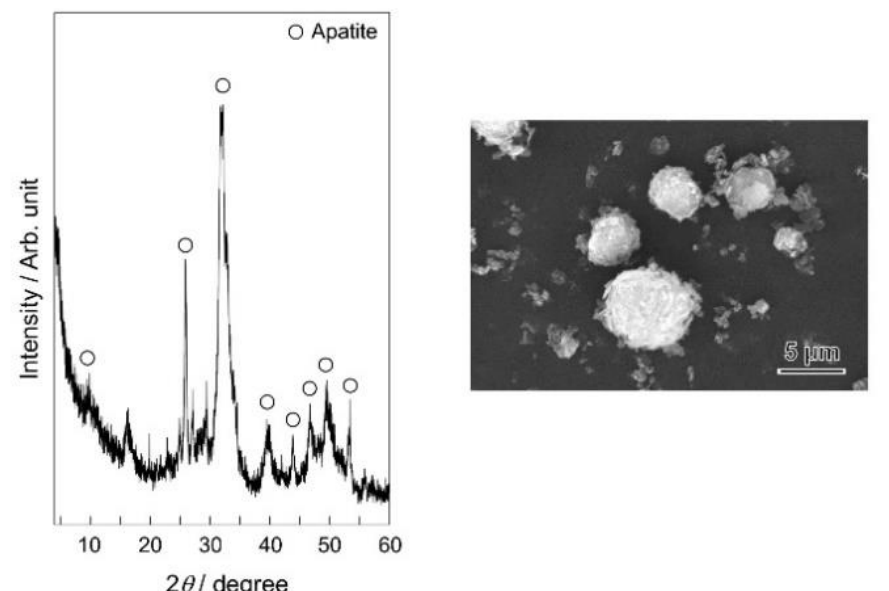
Figure 1. X-ray diffraction pattern and scanning electron microscope photograph of the microspheres obtained by H 3 PO 4 treatment of the vaterite microspheres.